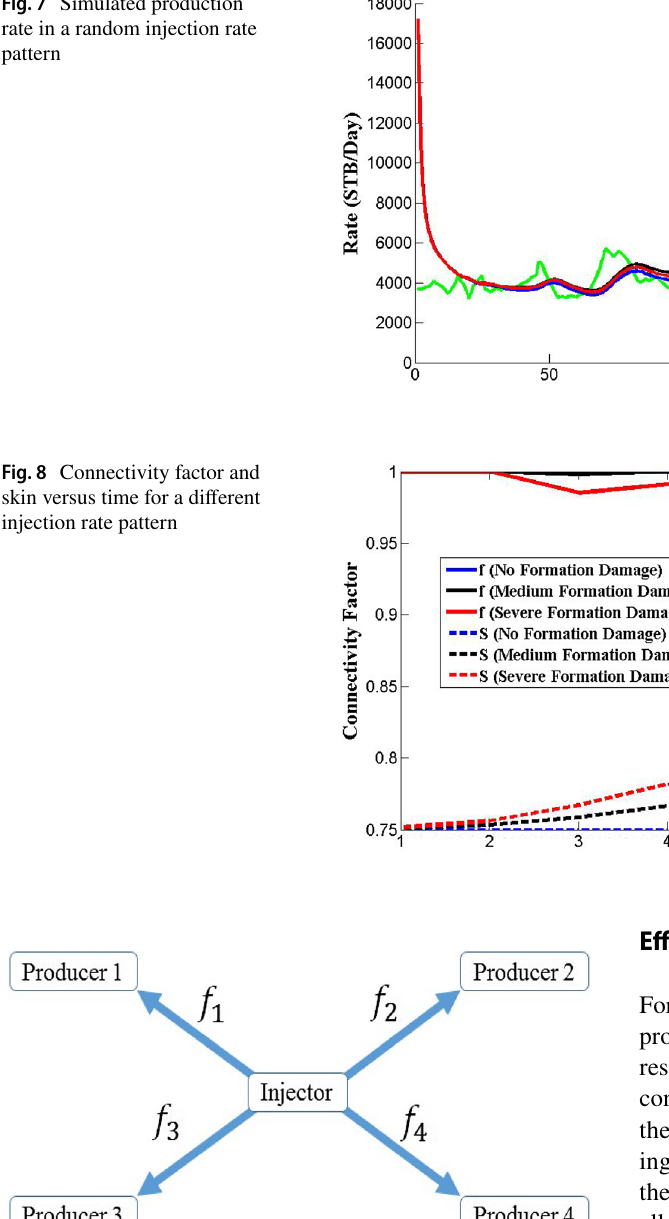
Fig. 7 Simulated production rate in a random injection rate pattern